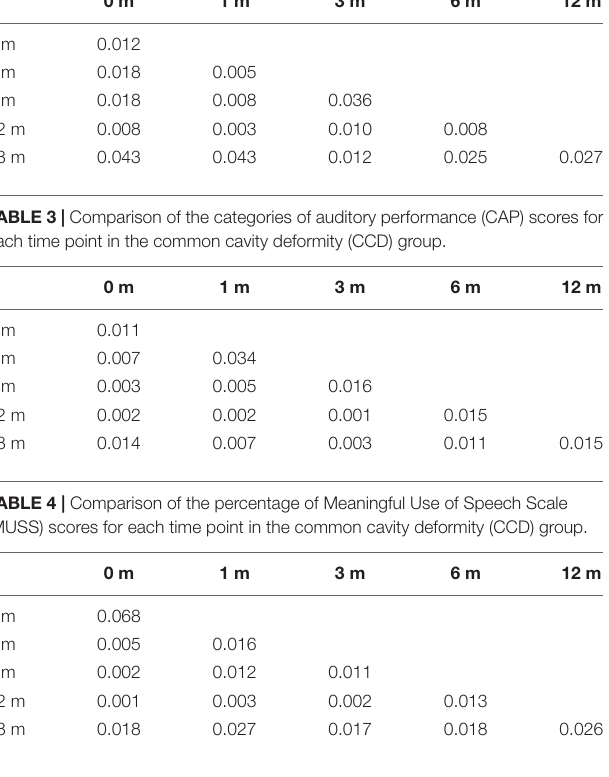
Maximum length of follow-up (M)